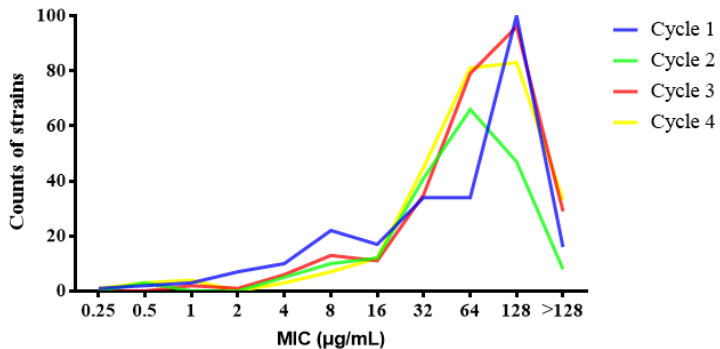
Figure 1. MIC value distribution of 983 strains of E. coli to enrofloxacin in four breeding.